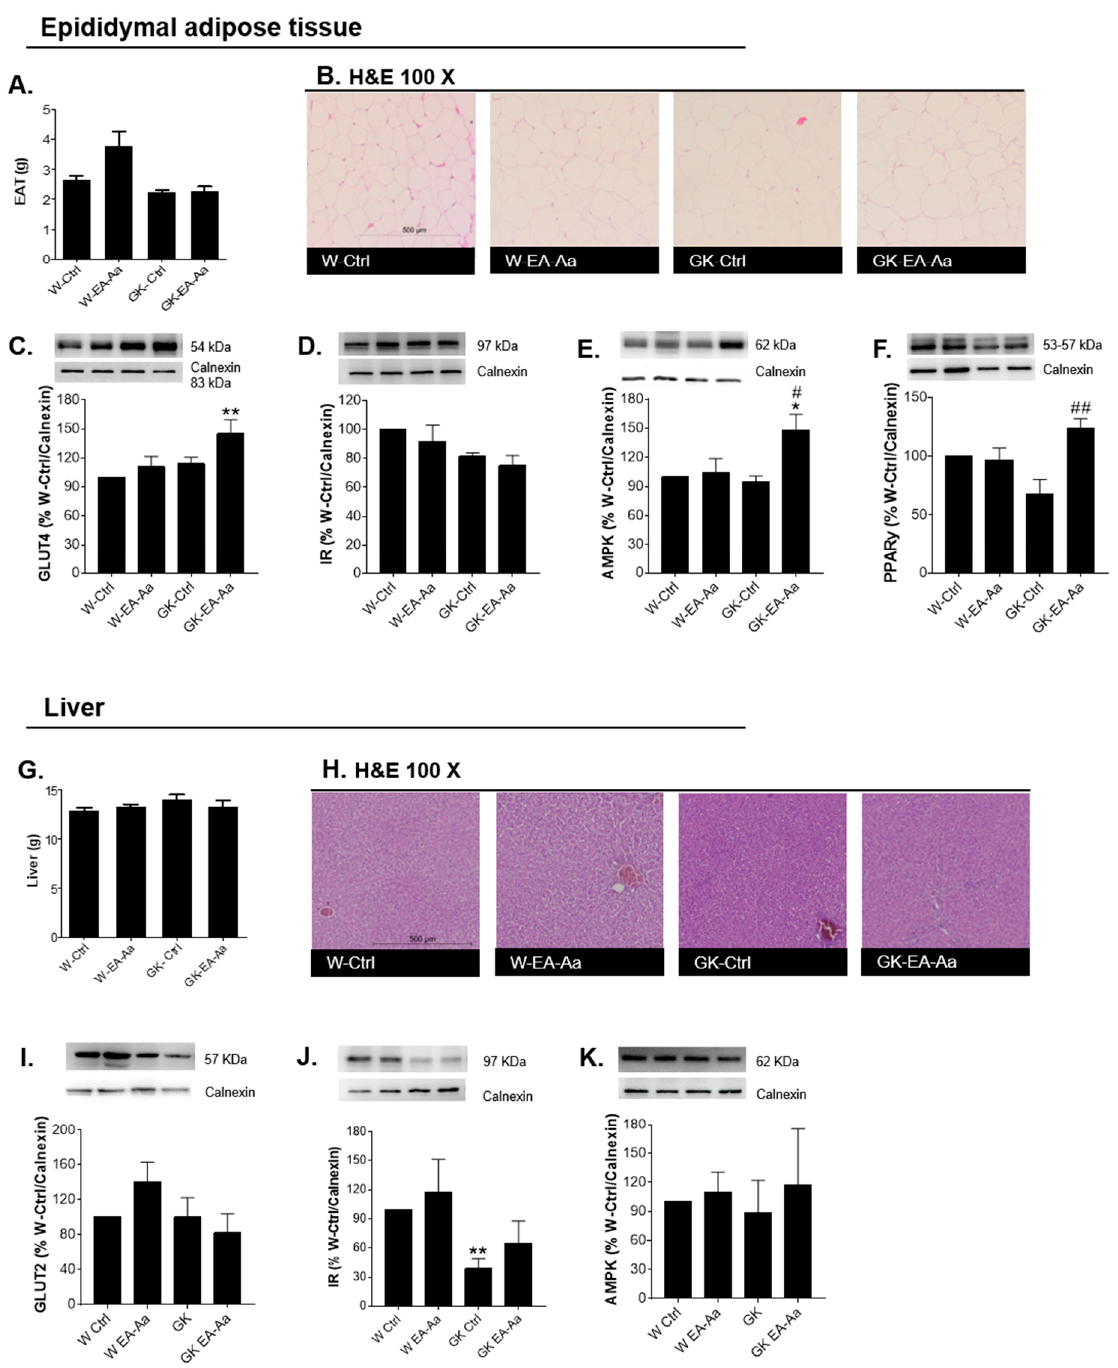
Figure 2. Regulation of metabolic pathways in epididymal adipose tissue (EAT) and liver. ( A ) Epididymal adipose tissue weight ( n = 5–7). ( B ) Haematoxylin-eosin staining in EAT ( n = 4). ( C ) GLUT4 levels in EAT; treatment with EA-Aa increased the levels of the protein in the treated diabetic group. ( D ) Insulin receptor levels in EAT. ( E ) AMPK levels in EAT; an increase in AMPK levels is presented in EA-Aa GK-treated group in relation to both controls. ( F ) PPAR γ levels in EAT; GK-EA-Aa shows an increase in relation to W-Ctrl group ( n = 5 for Western blots). ( G ) Liver weight ( n = 5–7). ( H ) Haematoxylin-eosin staining in liver ( n = 4). ( I ) GLUT2 levels in liver. ( J ) Insulin receptor levels in liver; treatment with EA-Aa promoted a restoration in IR levels in relation to the normal control group. ( K ) AMPK levels in liver ( n = 5 for Western blots). * vs. W-Ctrl; # vs. GK-Ctrl; *,# p < 0.05; **,## p < 0.01.